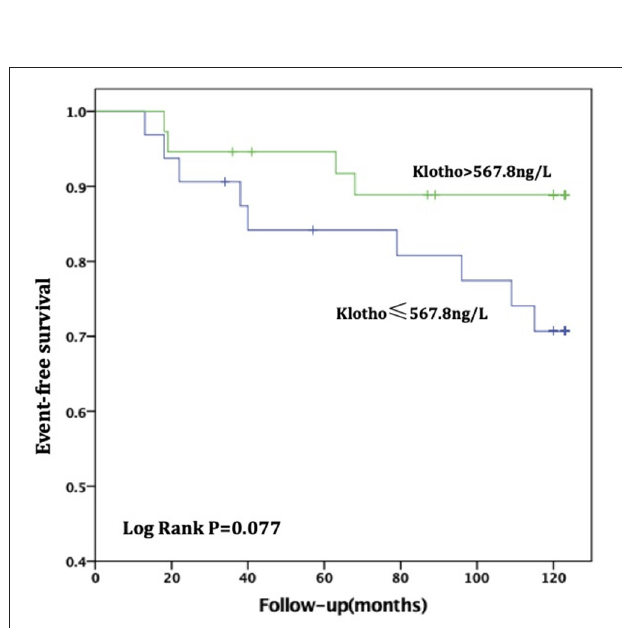
FIGURE 5 | AAC ≤ 4, Relationship between soluble Klotho level and All-cause mortality in MHD patients. For patients with no or mild calcification (AAC ≤ 4), the high level of soluble Klotho level (sKl > 567.8 ng/L) patients had a lower risk of all-cause death than in those with low level of soluble Klotho level (sKl ≤ 567.8 ng/L). But Kaplan-Meier analysis with log-rank test revealed no significant difference between groups ( P = 0.077).